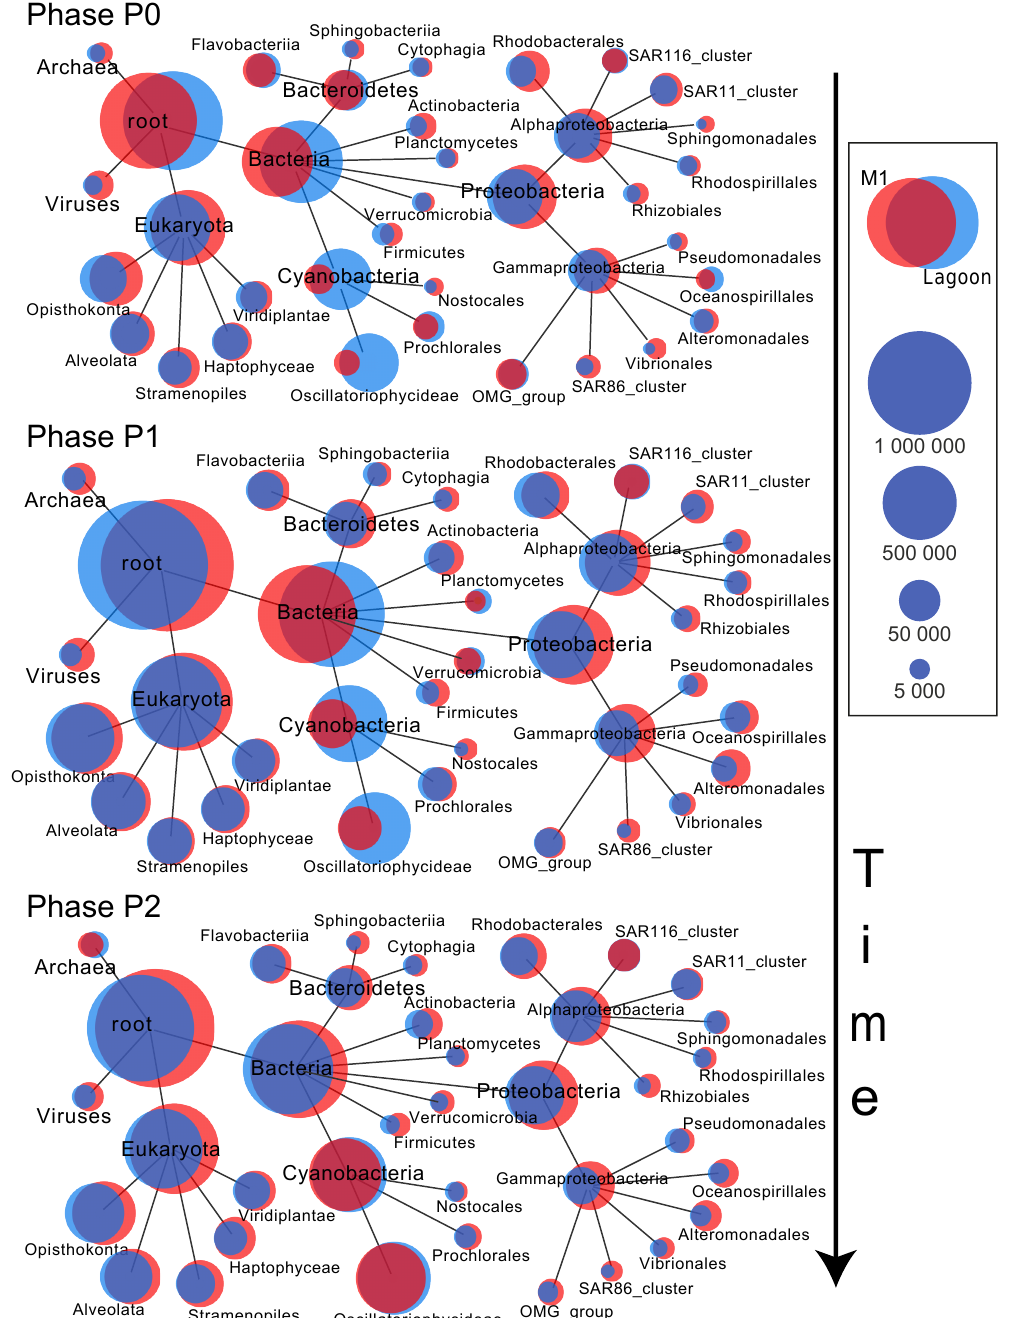
Figure 4. Comparison of the taxonomic affiliation of mRNA transcripts from M1 and the lagoon in the three chronological phases P0, P1, and P2, visualized with CoVennTree (Lott et al., 2015). Normalized transcript abundances (TMM-normalized TPM), displayed as the node area, were summed up per phase as follows. P0: day 2–day 4, P1: day 6–day 14, P2: day 16–day 23. The different sizes of the root nodes occur because different transcripts with differing total read abundances may be classifiable in the different data sets, and the data set normalization included all transcripts (also nonclassifiable). The overlap of the red (M1) and blue (lagoon) circles denotes the amount of transcripts present in both locations during the respective phase. The diagrams were reduced to show only major nodes and thus raise no claim to completeness. Yet, each node contains the information from all its children nodes, also those not shown. Archaea are scarcely represented in the current RefSeq protein database, thus their transcript abundances are underestimated